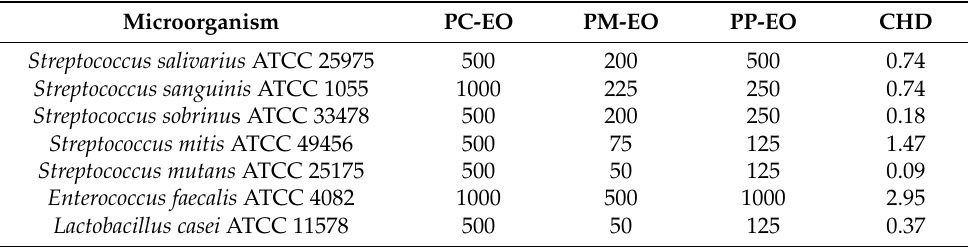
Table 2. In vitro antibacterial activity (MIC; µ g/mL) of the essential oils extracted from Piper margina- tum (PM-EO), Piper callosum (PC-EO), and Peperomia pellucida (PP-EO) against cariogenic